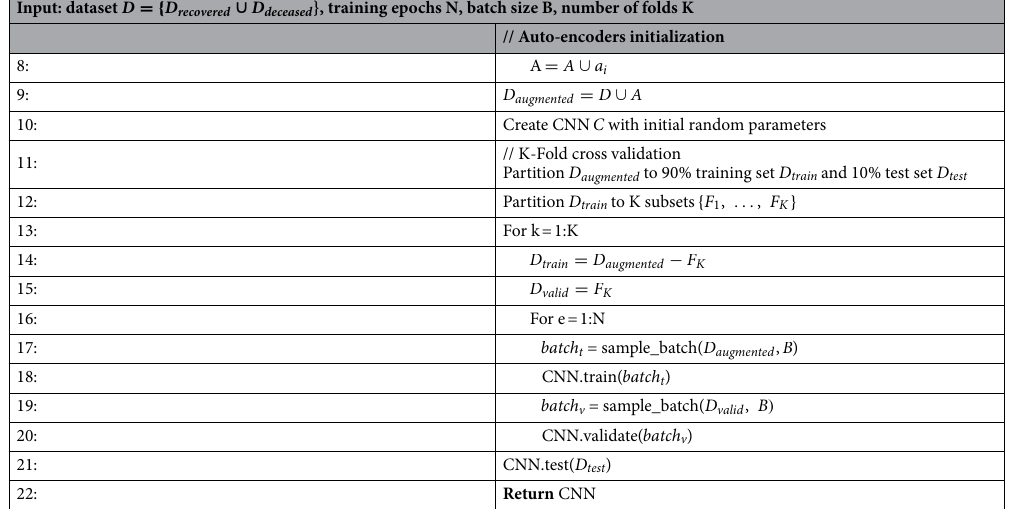
Algorithm 1. CNN-AE pseudo-code